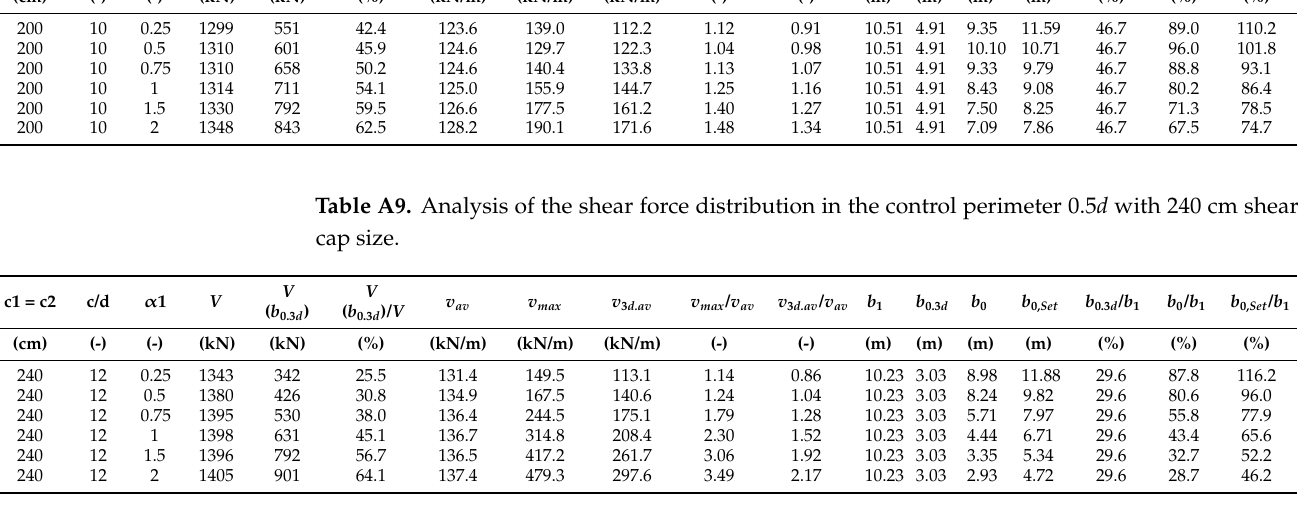
Table A10. Analysis of the shear force distribution in the control perimeter 2 d with 240 cm shear cap